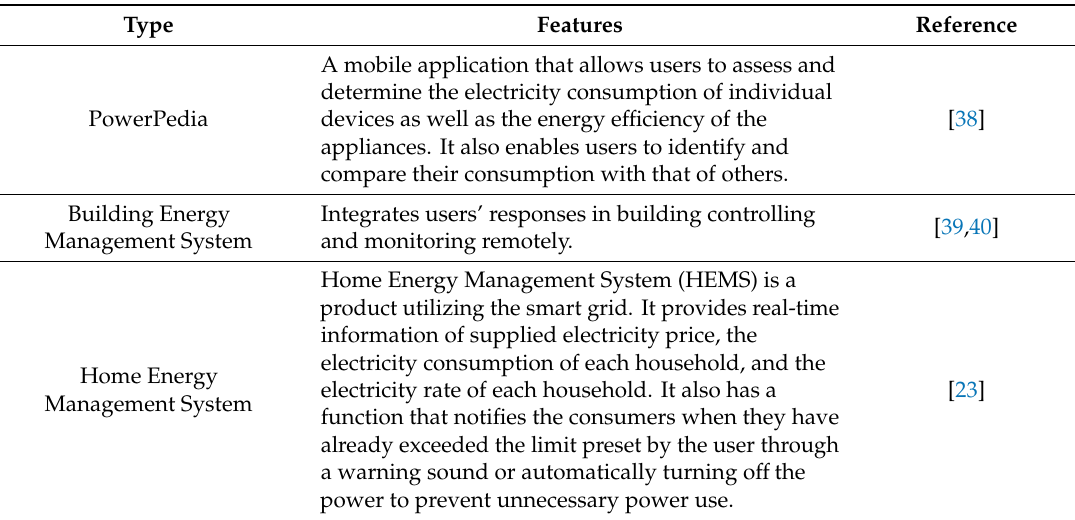
Table 2. Energy management